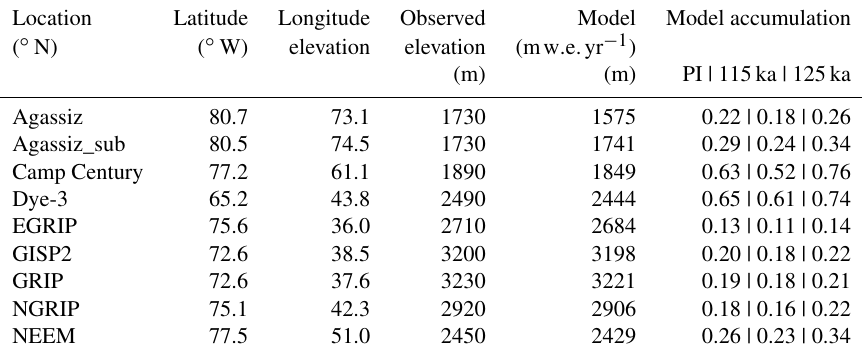
Table 1. Greenland ice core locations.